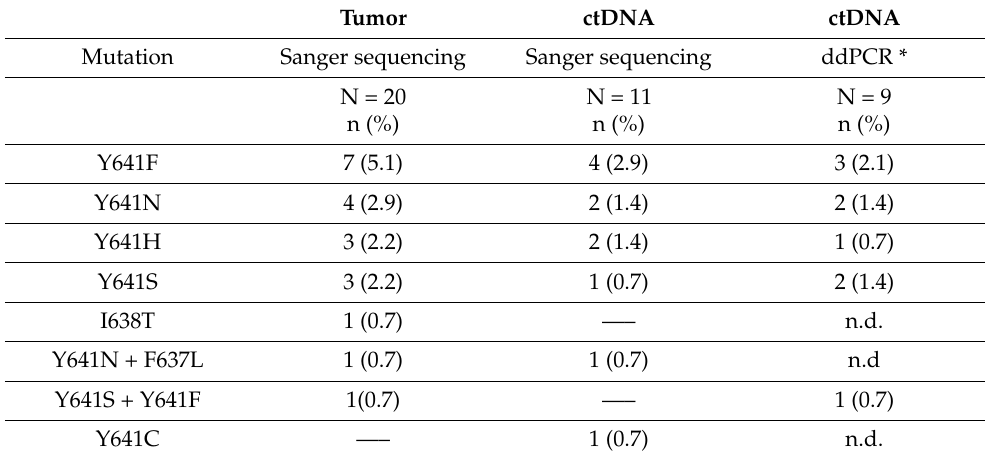
Table 2. Results and comparative analysis of EZH2 mutations in tumor and ctDNA